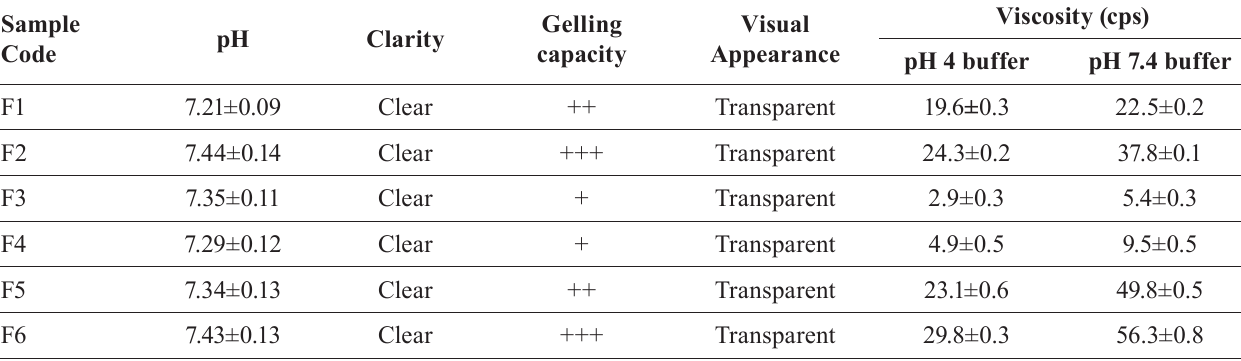
TABLE II - Physical characteristics of the formulations Sample